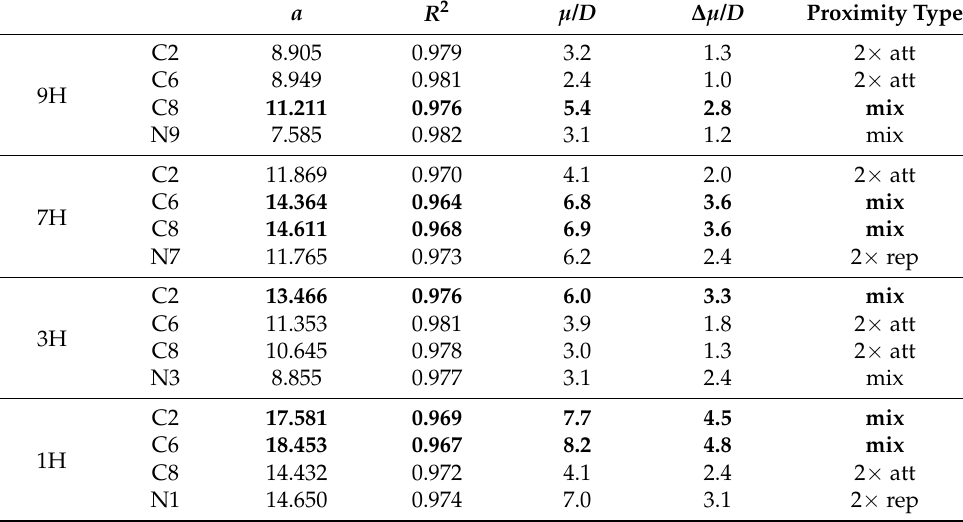
Table 4. Statistical data ( a and R 2 ) of E solv = a · (1/ ε ) + b linear fitting equations, where 1/ ε is the reciprocal of solvent dielectric constant (Table 1). Dipole moments for geometry in the gas phase, µ , and their changes due to solvation, ∆ µ = µ (FA) – E (GP). All data concern NH 2 derivatives of purine. C-NH 2 systems with mixed proximity type are marked in